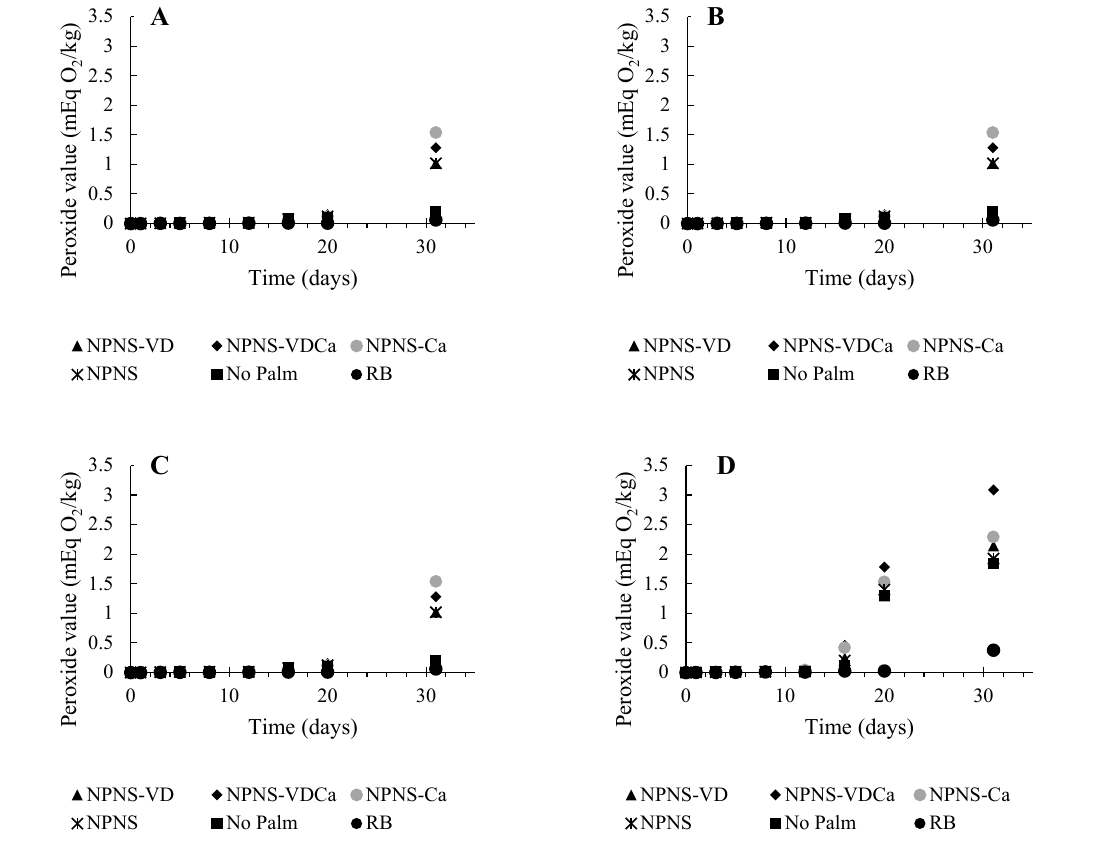
Figure 2. Peroxide value (mEq O2/kg) of the fat assessed for different chocolate spreads over 31 days of storage at 288.15 K ( A ), 303.15 K ( B ), 313.15 K ( C ), and 323.15 K ( D ). RB, reference brand; NPNS, spreadable chocolate without palm oil and sugar; NPNS-VD, spreadable chocolate without palm oil and sugar fortified with vitamin D; NPNS-VDCa, spreadable chocolate without palm oil and sugar fortified with vitamin D and Mg-CaCO 3 nanoparticles; NPNS-Ca, spreadable chocolate without palm oil and sugar fortified with Mg-CaCO 3 nanoparticles. The levels of PV at the zero time of storage were comparable among the different spreadable chocolates. The values ranged between 4.9 × 10 − 4 for the RB chocolate spread to 9.0 × 10 − 4 meq O 2 /kg oil for NPNS, and there was no significant difference among them. The PV steadily increased during the storage period as highlighted in Figure 2, showing the PV of the spreadable chocolates stored at 288.15, 303.15, 313.15, and 323.15 K plotted versus time. This trend, although observed in all formulations, was less marked for the RB sample. These results are consistent with the RB composition, characterized by high saturated fat concentration, and could also be linked to the lower water activity (a w ) and moisture content of the RB formulation (Figure 3).